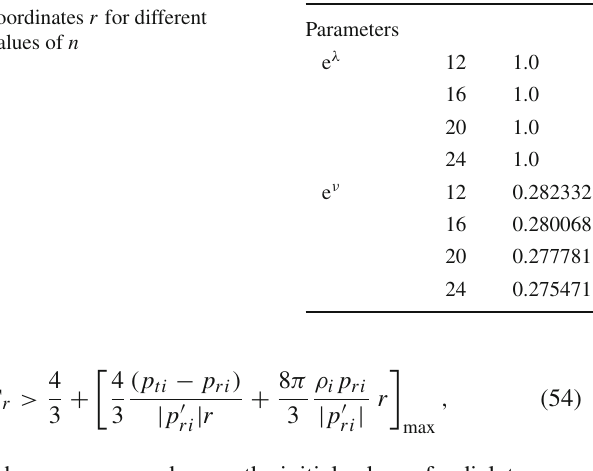
Table 3 Variation of metric potentials with radial coordinates r for different values of n